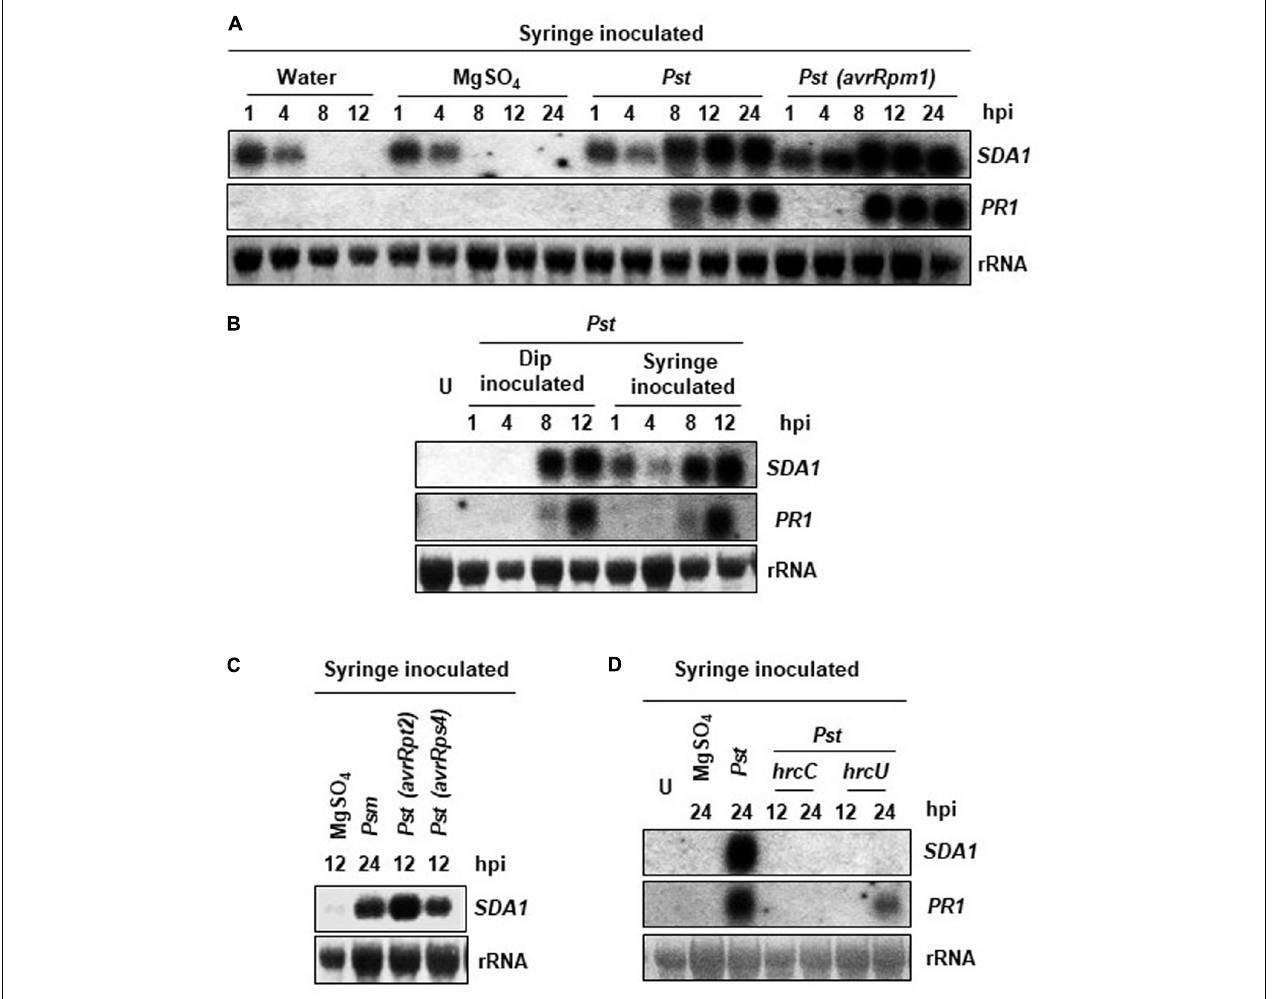
FIGURE 1 | Expression analysis of the SDA1 gene in response to bacterial pathogens. (A–D) Leaves of 4-week-old WT Col-0 plants were either syringe or dip inoculated with the indicated pathogens at a titer of 5 × 10 7 cfu/mL in 10 mM MgSO 4 . Mock treatment was performed with 10 mM MgSO 4 . Tissue samples were harvested at the indicated hpi (hours post-inoculation). RNA was isolated and transcript levels were determined by RNA gel-blot analysis. Blots were stained with methylene blue to show the relative amounts of RNA in each lane (28S rRNA). Blots were probed with the SDA1 gene probe, stripped and re-probed with the PR1 gene probe. All experiments were repeated at least twice and similar results were obtained. Pst, Pst DC3000; Psm, Psm ES4326; avrRpm1, Pst DC3000 ( avrRpm1 ); avrRps4, Pst DC3000 ( avrRps4 ); hrcC , hrp mutant of Pst with a mutation in hrcC gene; hrcU , hrp mutant of Pst with mutation in hrcU gene; U,